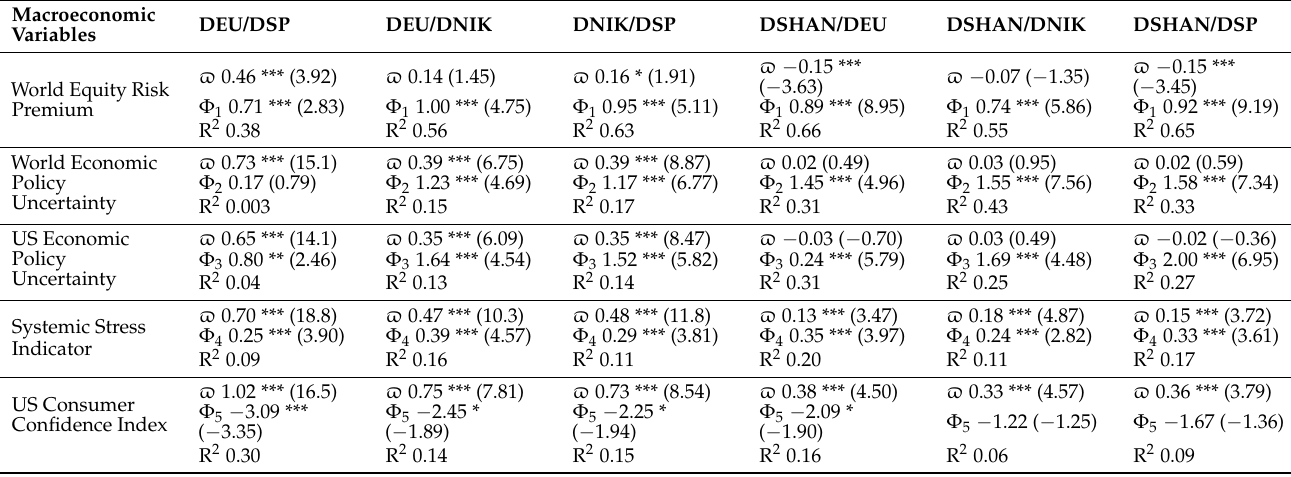
Table 6. Dynamic Conditional Correlations between Stock Market Returns and Macroeconomic Variables. Sample 2000M11– 2019M3 (221